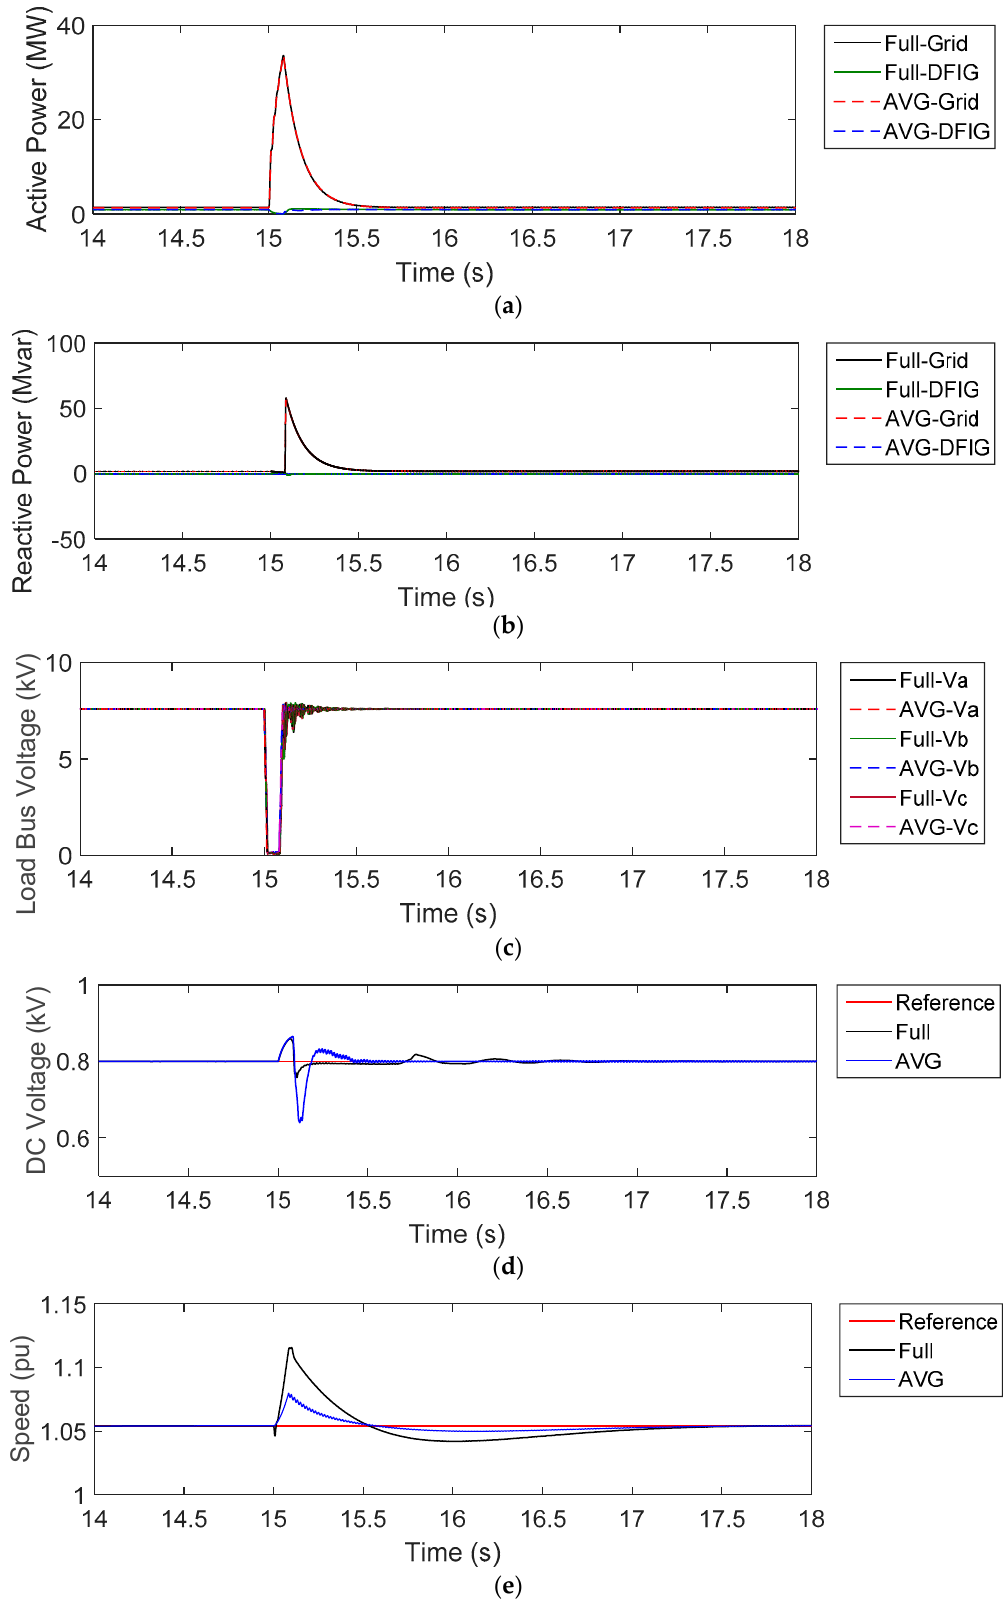
Figure 9. Outputs to ground fault of 0.1 Ω at HV side of substation transformer with balanced loads: ( a ) active power outputs, ( b ) reactive power outputs, ( c ) load bus voltage, ( d ) DC voltage, ( e ) DFIG speed.